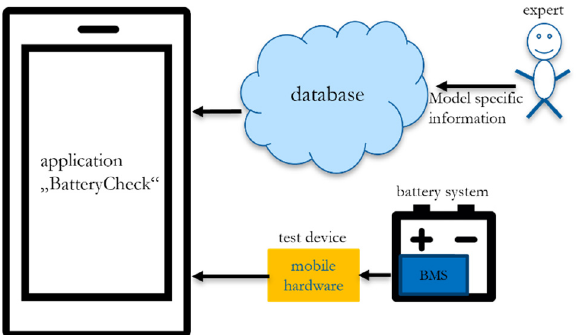
Figure 6. Data context of the application “BatteryCheck”: Besides the data read from the battery’s BMS with the mobile hardware, the application is taking model-specific information from a backend database, which includes expert knowledge needed to decode the raw CAN-data.